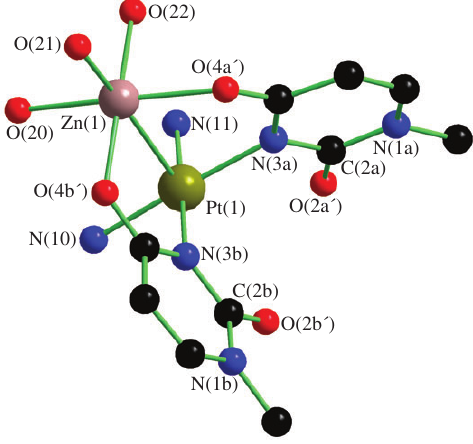
Figure 6 Structure of [Pt(NH et al.,